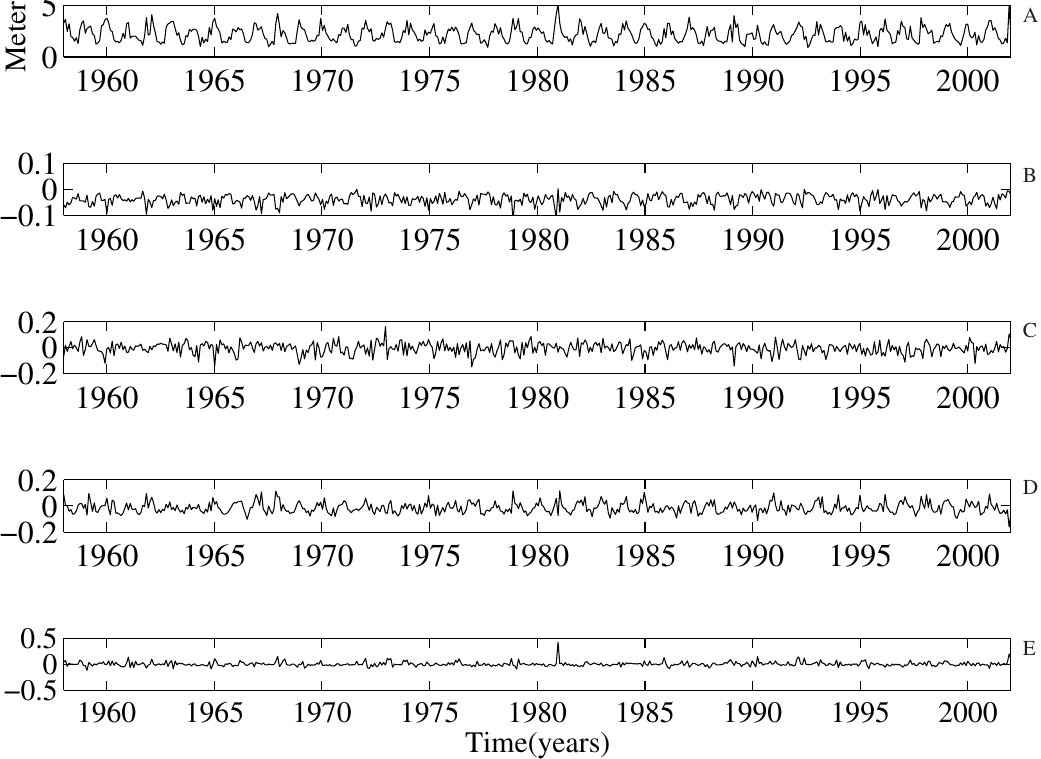
Fig . 8. – time evolution of the spatial mean computed from 528 months for the 95 th percentile sWH (a), 2 nd , 3 rd and 4 th eof time amplitudes (B, C, d,